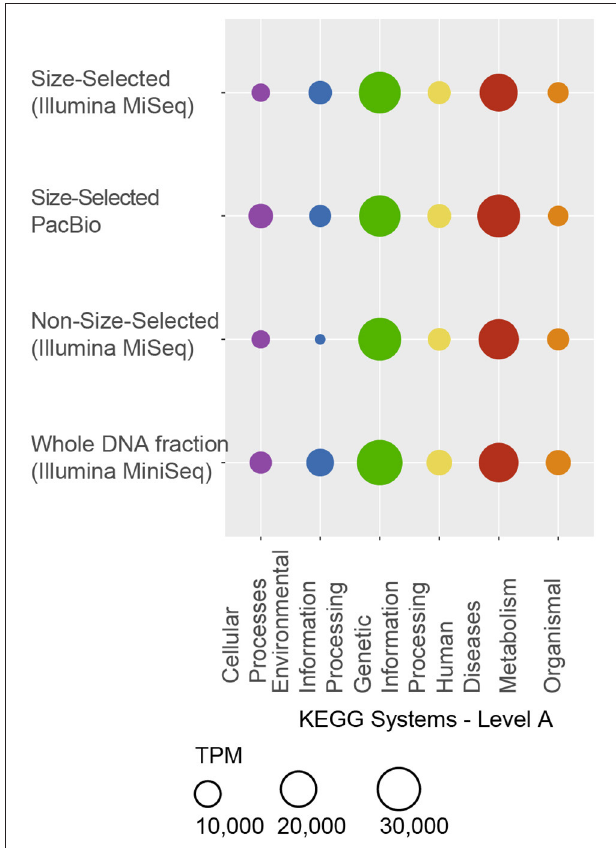
FIGURE 7 | Distirbution of functional genes represented in the transcriptome. KEGG systems are indicated on the x-axis, and the sequencing approach is shown on the y-axis. Many genes mapped to more than one function and to more than one category. Similarly to Figure 6 , all genes mapping to “Organismal” and “Human Diseases” also mapped to other systems. A full list of KO numbers with mapped RNA reads is provided in the supplement. Genes with roles in pathways within the “Genetic Information Processing” and “Metabolism” systems were the most abundantly expressed.